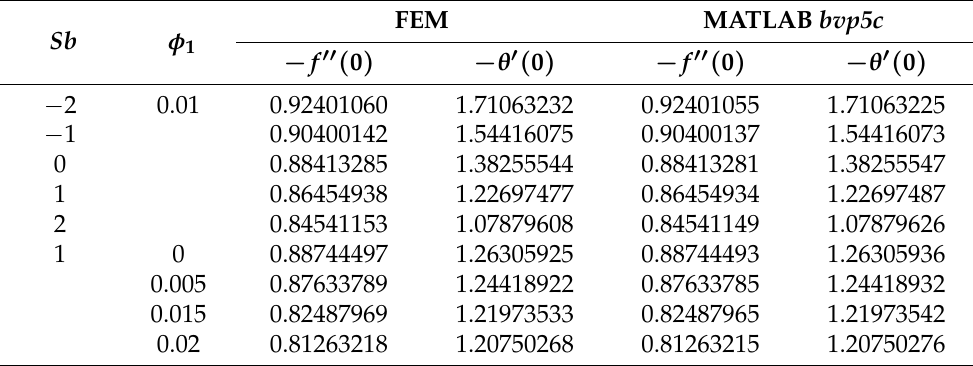
Table 4. Validation of present FEM results with MATLAB bvp5c for the parametric